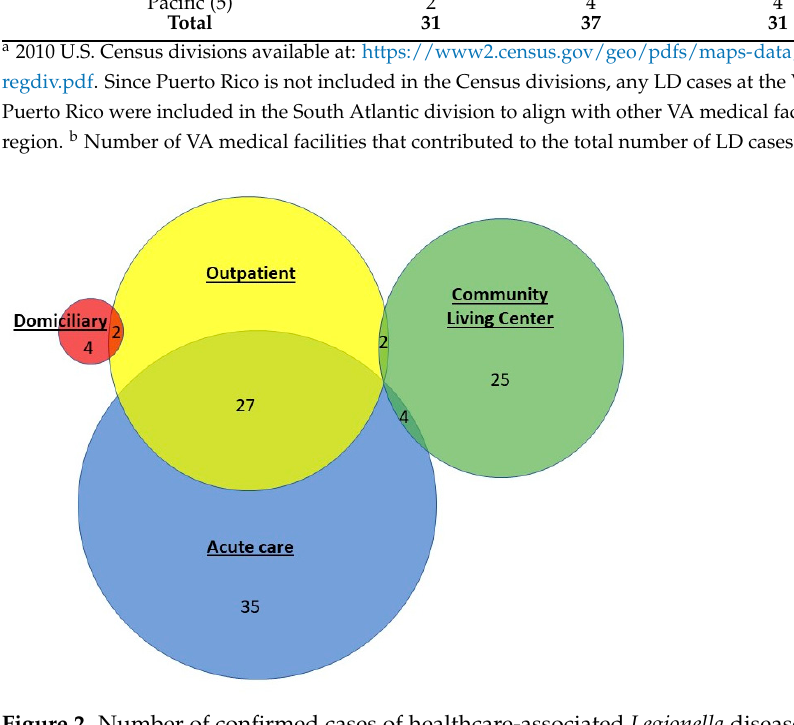
Figure 2. Number of confirmed cases of healthcare-associated Legionella disease by VA healthcare setting exposure. For this depiction, the section of the diagram with only acute care exposure (n = 35) includes four cases that had spinal cord injury unit contact only.